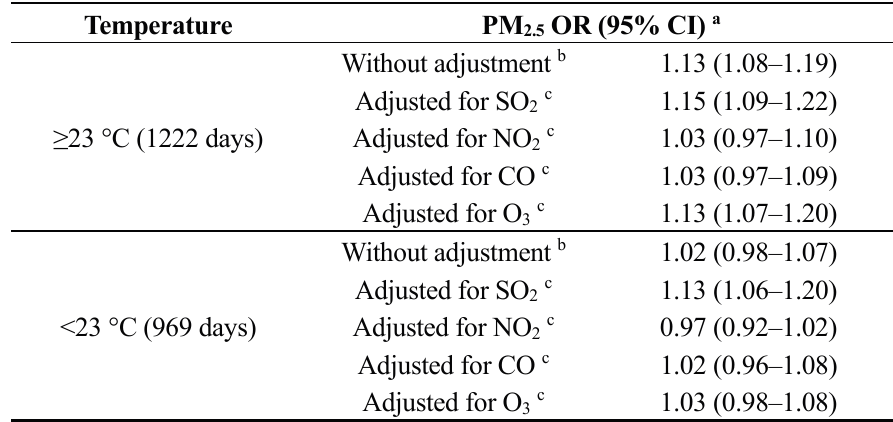
Table 3. Association between PM 2.5 exposure and clinic visits for migraine in Taipei, Taiwan,